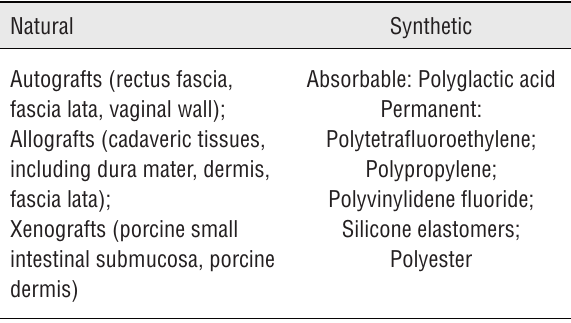
Table 2 - Biomaterials Options For Soft Tissue Repair. Natural Synthetic Autografts (rectus fascia, fascia lata, vaginal wall); Allografts (cadaveric tissues, including dura mater, dermis, fascia